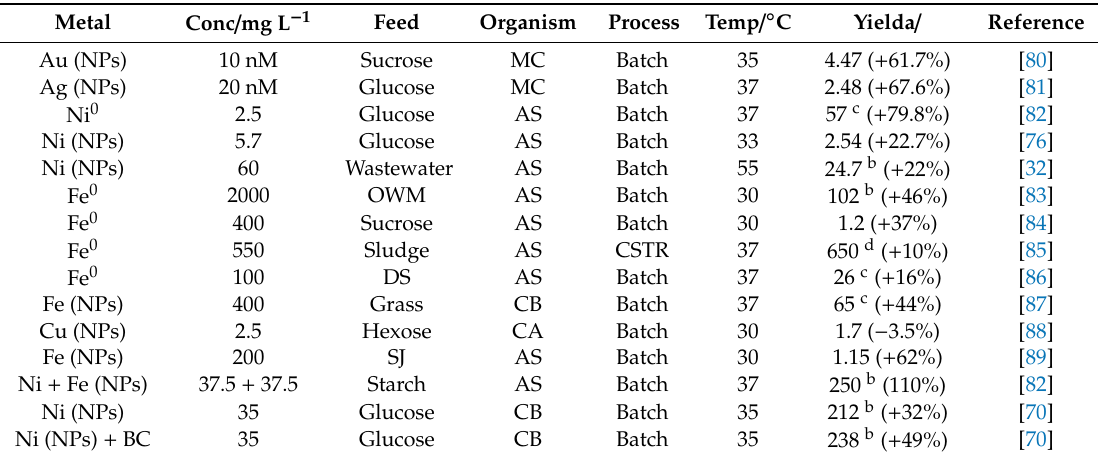
Table 2. Summary and comparisons of bio-hydrogen production with addition of metal monomers and